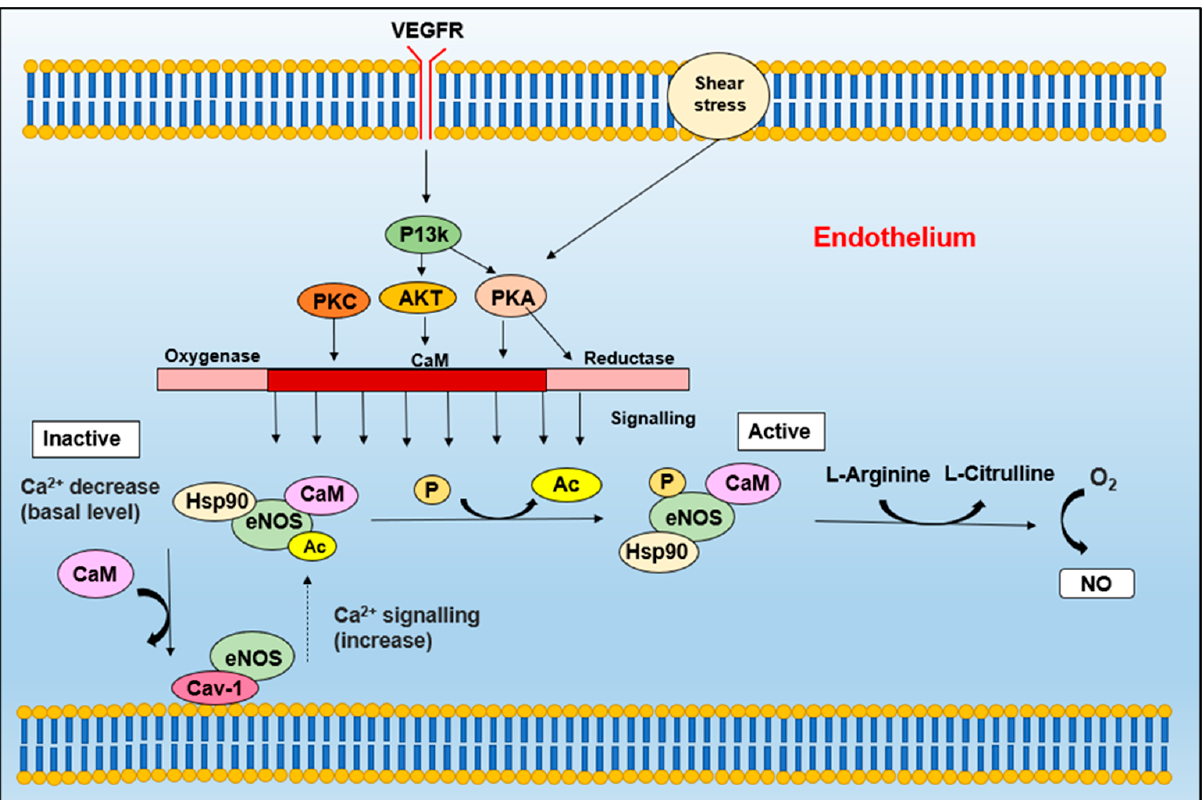
Figure 3. eNOS is activated by an increase in Ca 2+ levels, which recruits CaM and Hsp90 to the enzyme, prompting caveolae (Cav-1) to dissociate from eNOS [60]. The activity of CaM and Hsp90 is promoted by EGF, which promotes CaM expression and the recruitment of Hsp90 [60]. The eNOS complex can then be activated by the phosphorylation of eNOS, which occurs via PKA (activated by shear stress), VEGF (via Ser/Thr kinase Akt), insulin, and bradykinin, which is regulated by Ca 2+ /calmodulin-dependent protein kinase II (CaMKII) [60]. These stimuli result in the dissociation of adenylate cyclase (Ac) from eNOS. The eNOS complex can then catalyze the production of L -citrulline and NO from L -arginine, and thus increase NO generation.